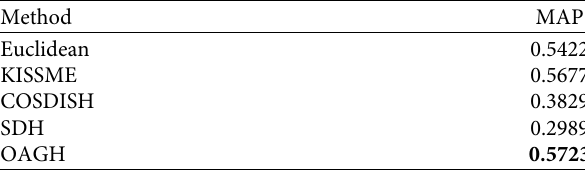
Table 2: Comparison of MAP results on Market-1501 dataset. Method